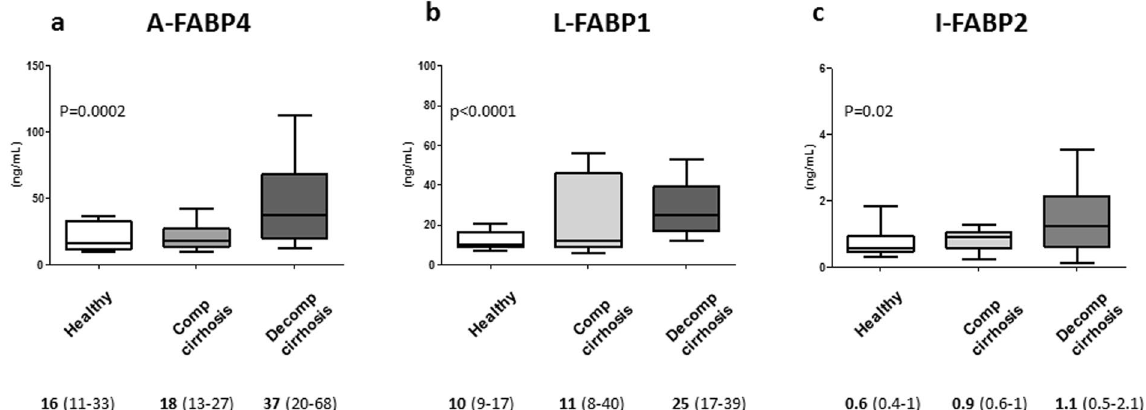
Figure 1. Plasma levels of FABPs in patients with decompensated cirrhosis compared to patients with compensated cirrhosis and healthy subjects. Panel a shows plasma levels of adipocyte fatty-acid binding protein 4 (A-FABP4), panel b shows plasma levels of liver fatty-acid binding protein 1 (L-FABP1), and panel c shows plasma levels of intestinal fatty-acid binding protein 2 (I-FABP2). Values shown below the panels are plasma levels of FABPs expressed as median and inter-quartile range.